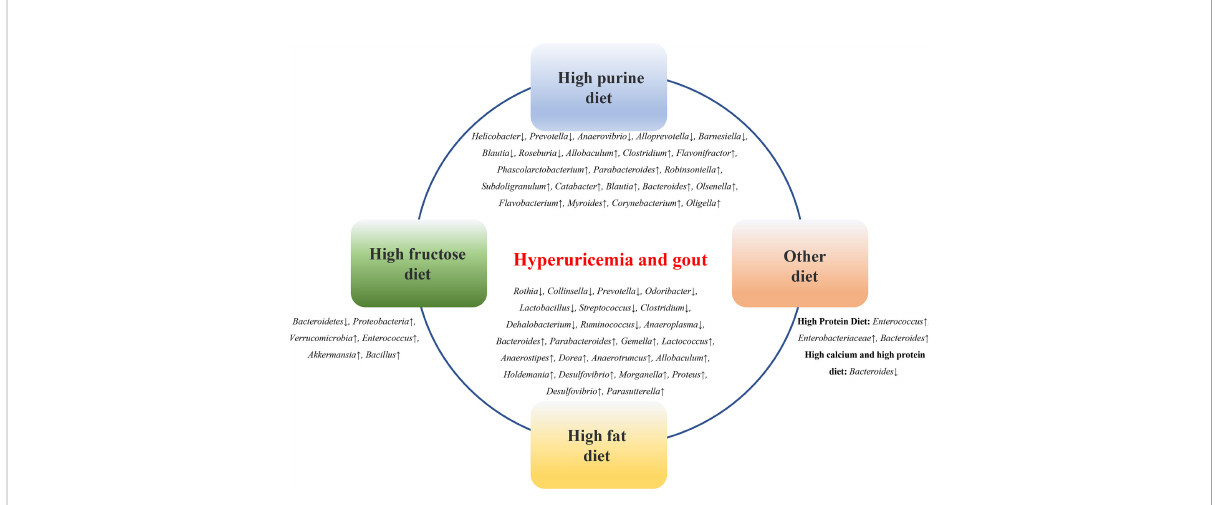
FIGURE 2 Diets affect the microbial composition of the gastrointestinal tract. High-fructose diet, high-fat diet, high-purine diet, etc. can lead to changes in the composition of intestinal fl ora in animal models of HUA and